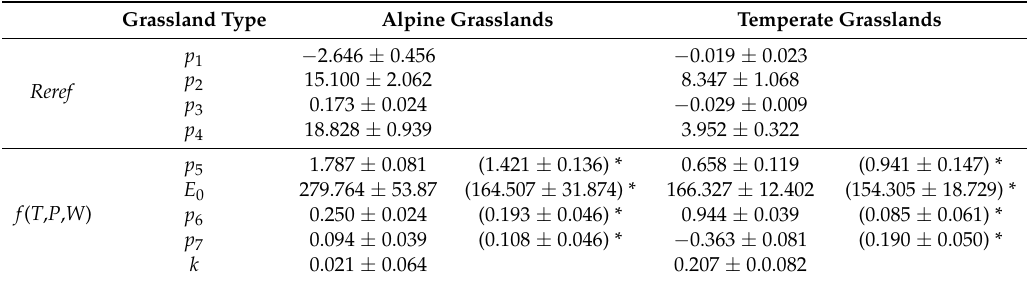
Table 2. Parameter estimation of Reref and f ( T , P , W ) for two grassland types in two regions. Grassland